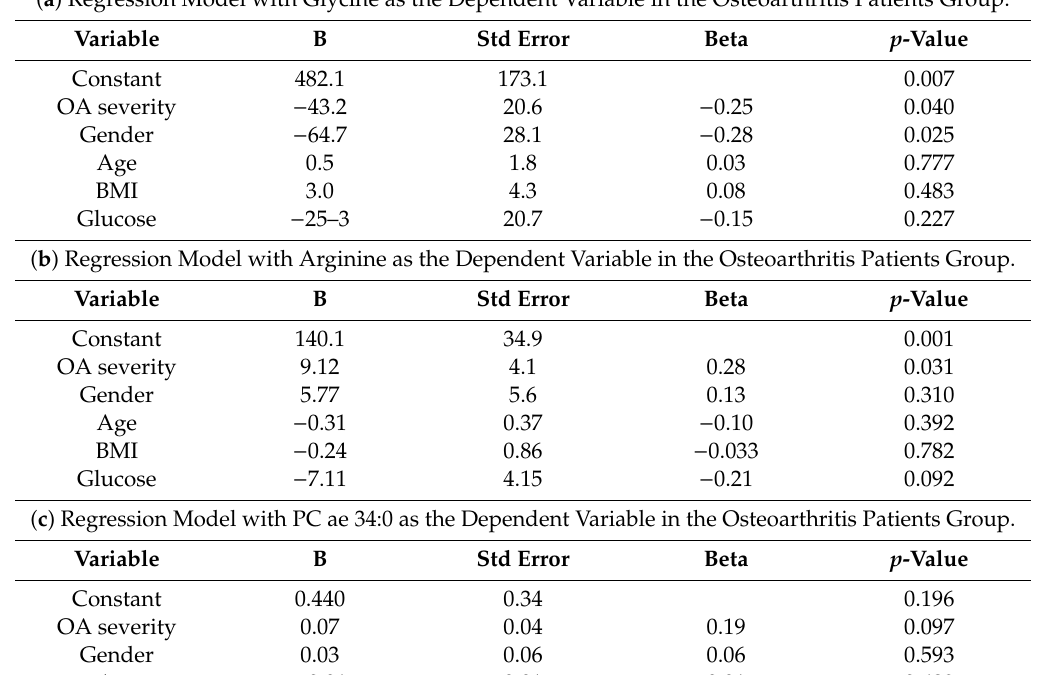
Table 4. Multiple regression analysis models for significant correlations from the univariate